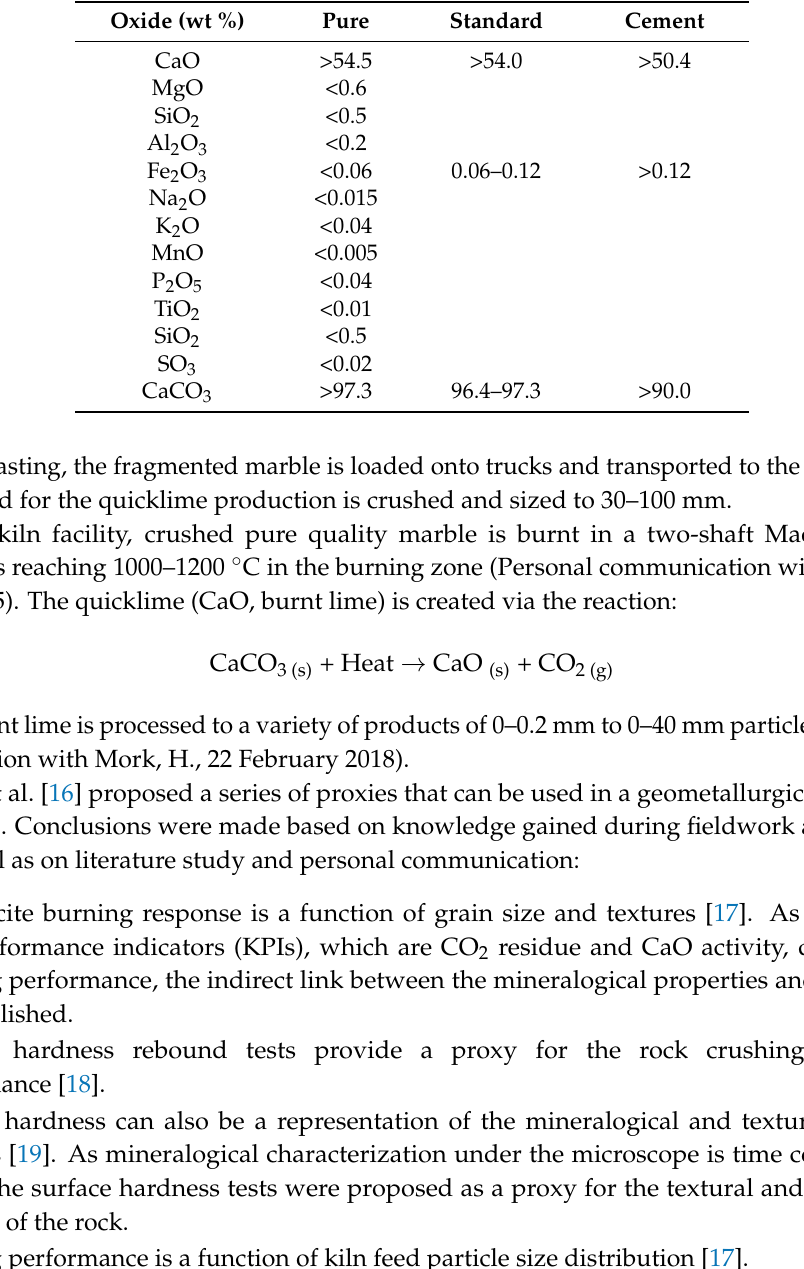
Table 1. Quality demands for Verdalskalk deposit. Values in percentage by weight